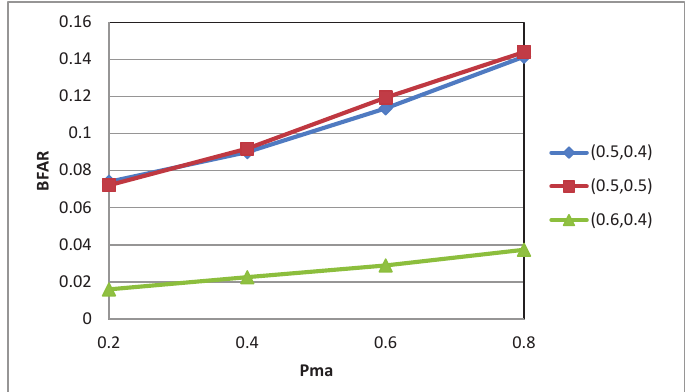
= r when r ma e c